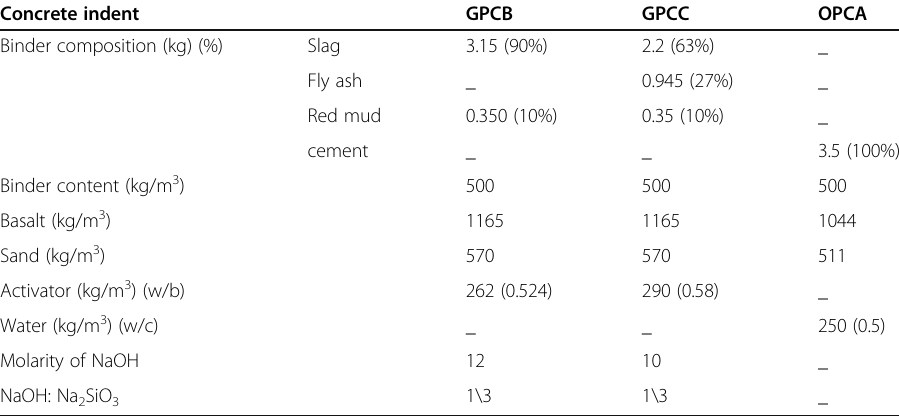
Table 5 Mix id and mix batch composition of concrete mixes Concrete